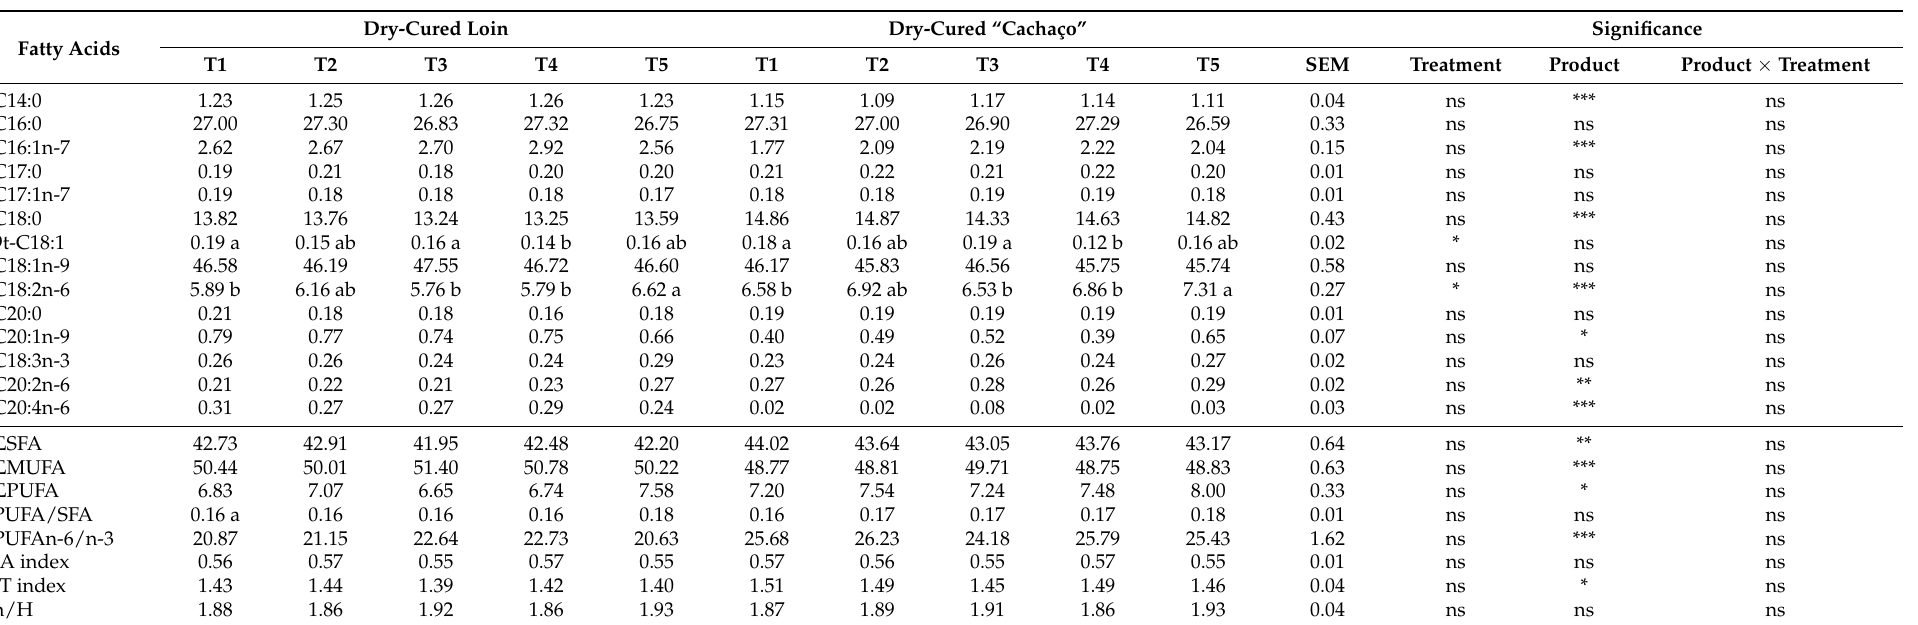
Table 2. Fatty acids profile (g/100 g) of dry-cured loin and dry-cured “cachaço” of the B í saro pig breed. Effect of treatment with olive cake, product, and interaction between product and